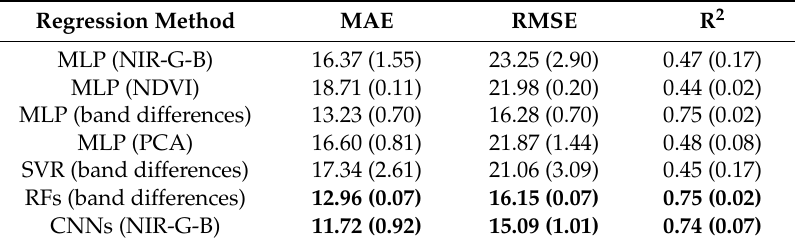
Table 1. Summary of Regression